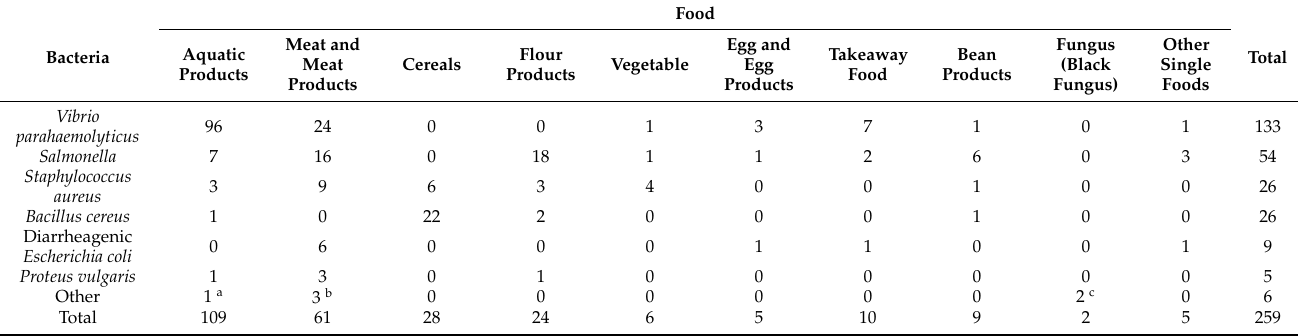
Table 5. Food-etiology distribution of bacterial FBDOs in Zhejiang Province,